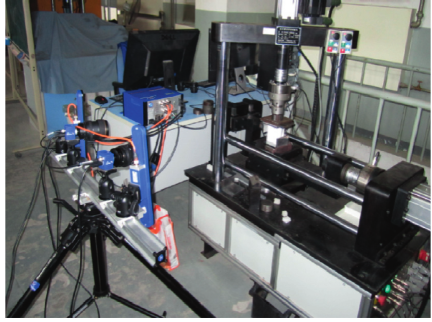
Figure 3: Direct shear test equipment with